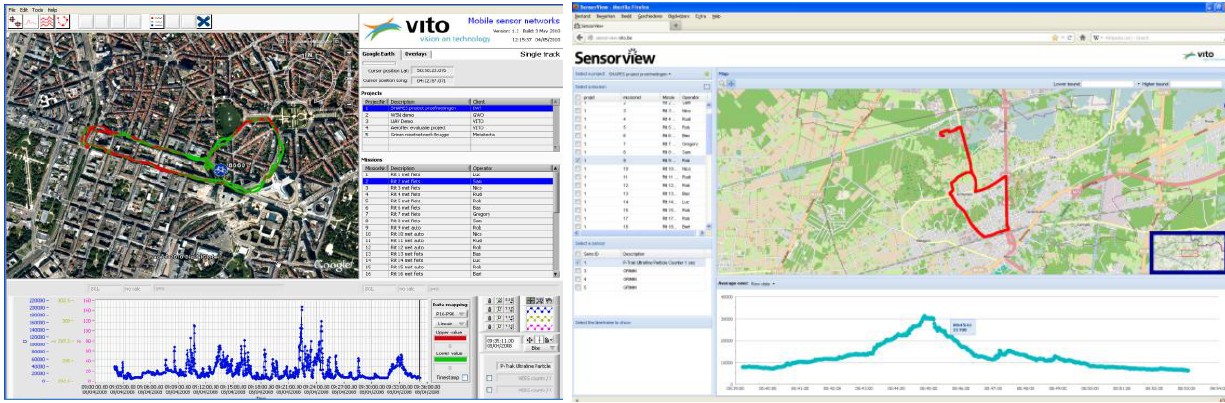
Figure 5. Desktop application for automated visualization of Aeroflex measurements (left). Web application for automated visualization of Aeroflex rides